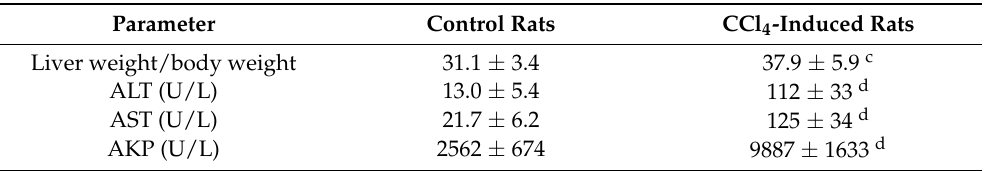
Table 1. The liver index and biochemical parameters of control and CCl 4 -induced rats. Data are expressed as mean ± S.D. ( n =